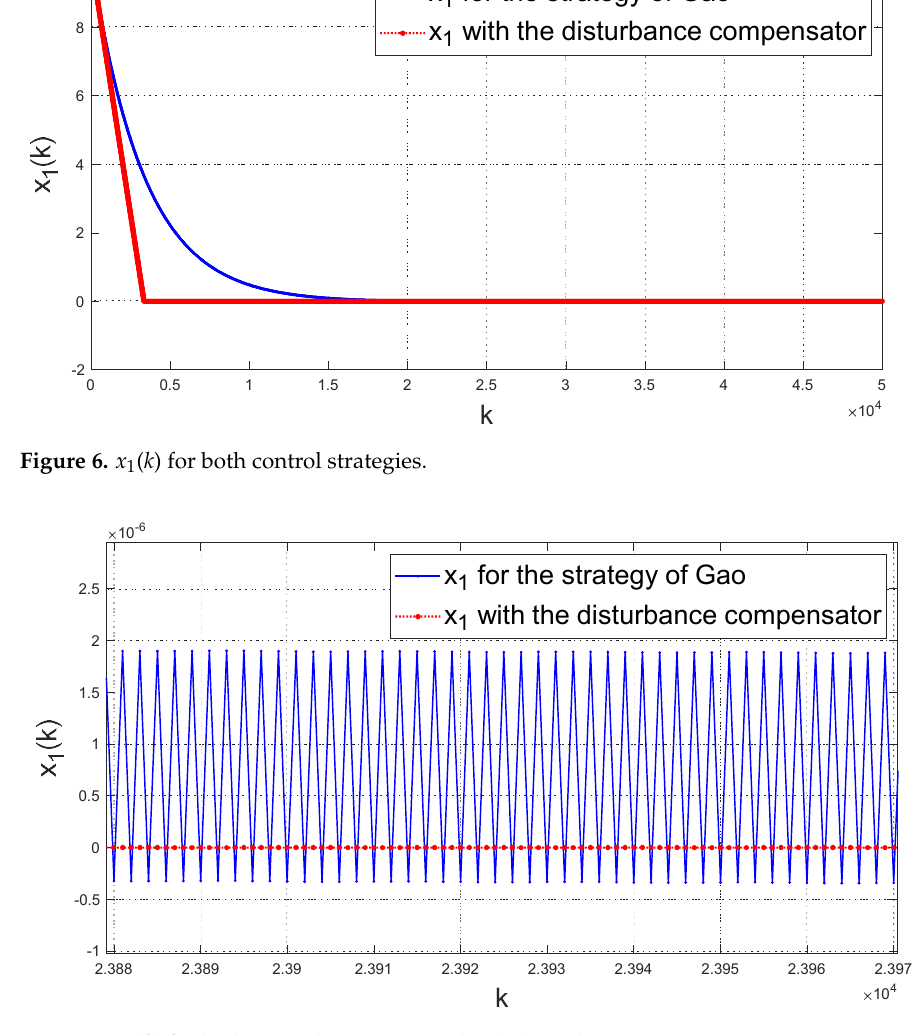
Figure 7. x 1 ( k ) for both control strategies in the sliding phase.